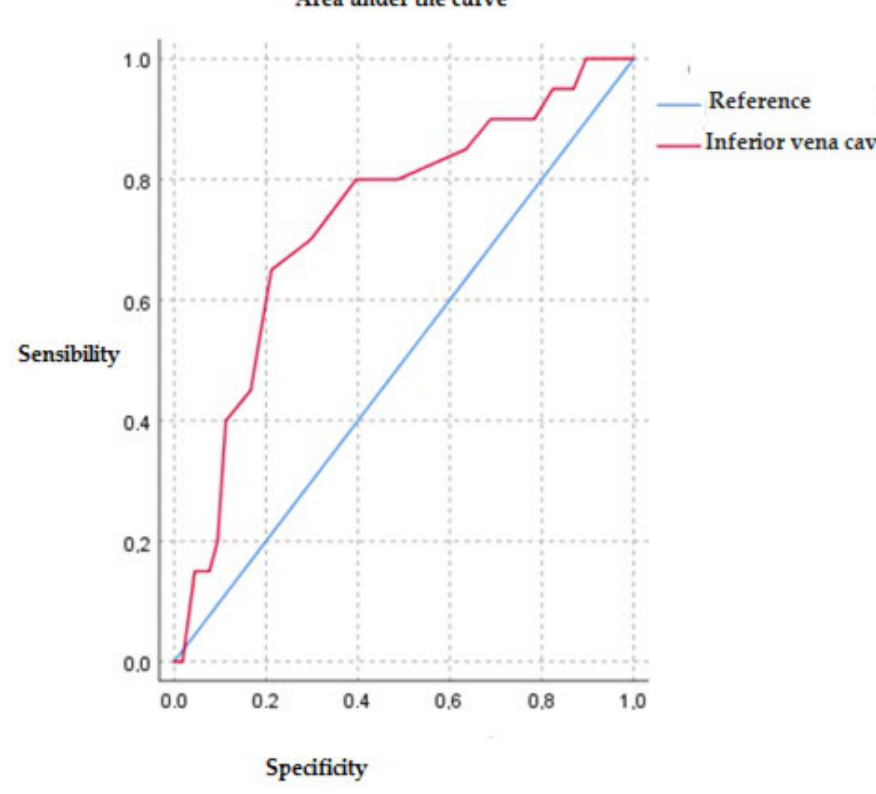
Figure 1. Analysis of the area under the curve for inferior vena cava diameter (mm) and 30-day mortality.